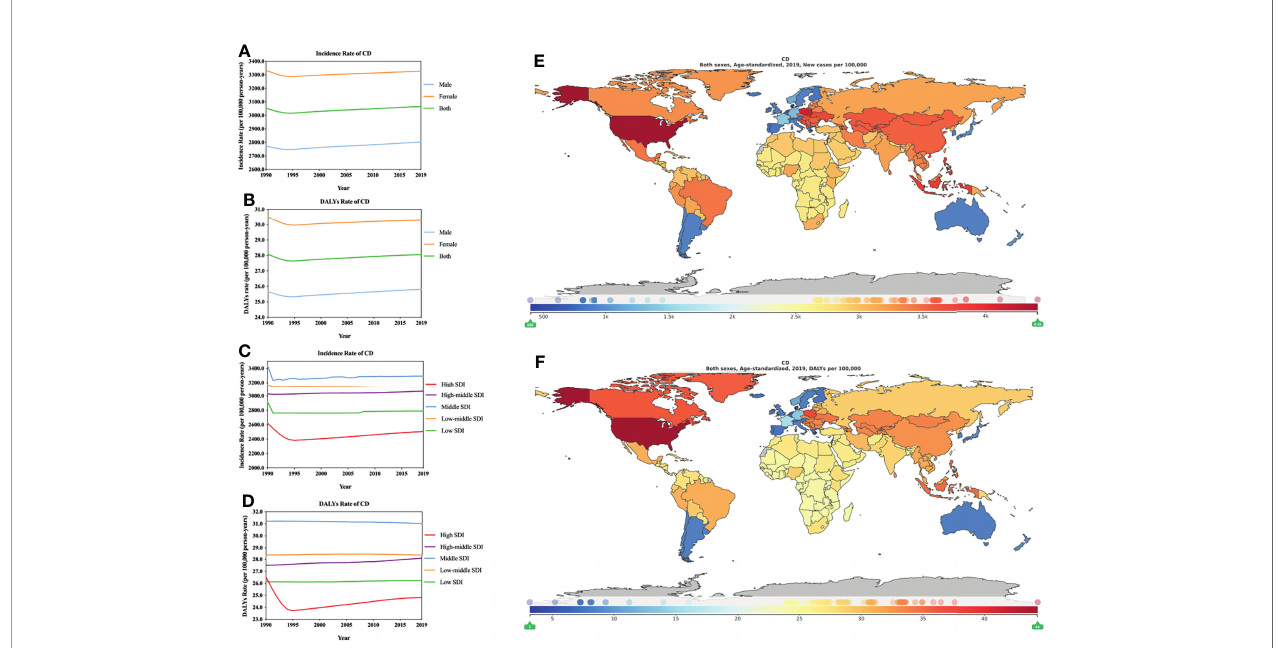
FIGURE 3 | Burden of CD for 204 countries and territories. ASIR ( A , by sex; C , by SDI) and ASDR ( B , by sex; D , by SDI) per 100,000 population of CD (1990 – 2019) by country and region. The distribution of ASIR (E) and ASDR (F) per 100,000 population of CD globally in 2019. Figures (E, F) were generated by